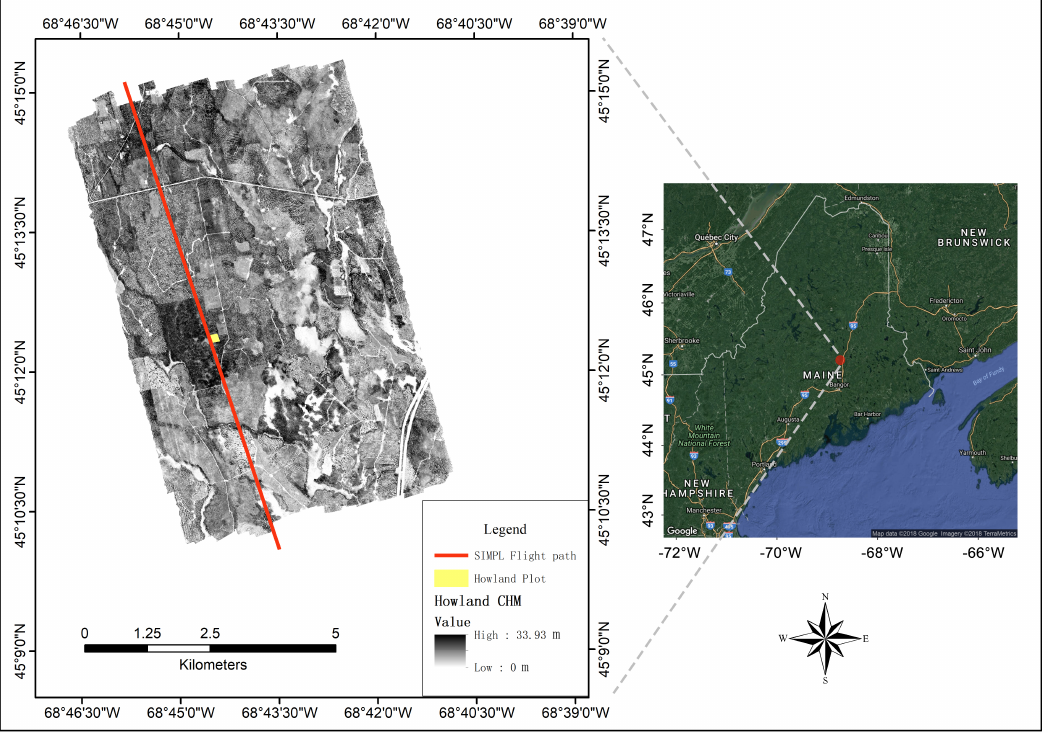
Figure 1. The location ( right ) of the Howland forest area, and image ( left ) of the Goddard’s LiDAR, Hyperspectral and Thermal Imager (G-LiHT) Canopy Height Model (CHM); the red line represents the SIMPL